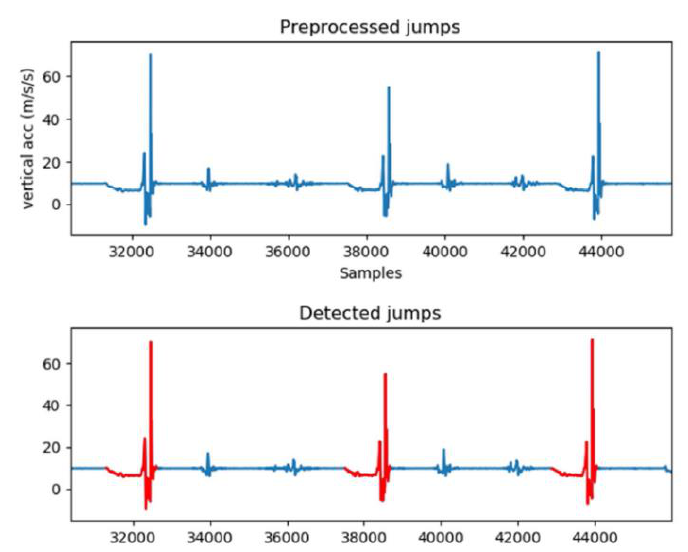
Figure 9. The jumping activity recognition algorithm. On top, the vertical acceleration signal of a recording including three consecutive jumps; the bottom figure (in red) depicts the part of the signal that the algorithm has classified as separate jumps.